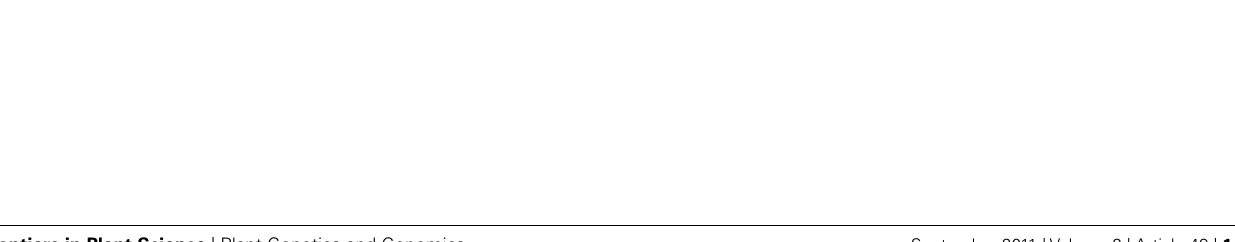
FIGUREA1 | Grain yield of the two maize inbred lines, SRG-100, and SRG-200 and its hybrid SRG-150 growing under greenhouse condition in the presence of 4mM Potassium nitrate. Plants were hand pollinated with the same pollen